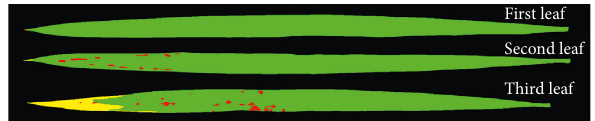
Figure 9: Comparison of symptoms between different leaf positions.